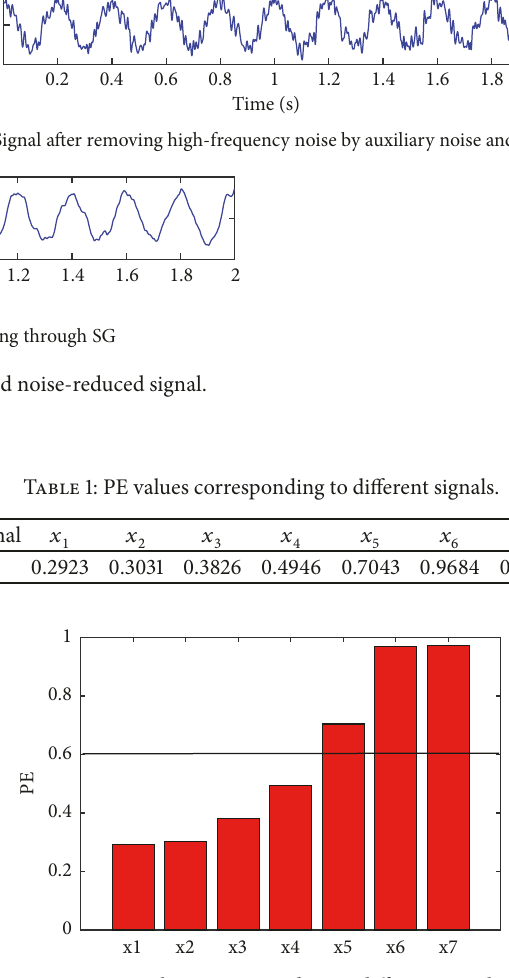
Figure 2: PE values corresponding to different